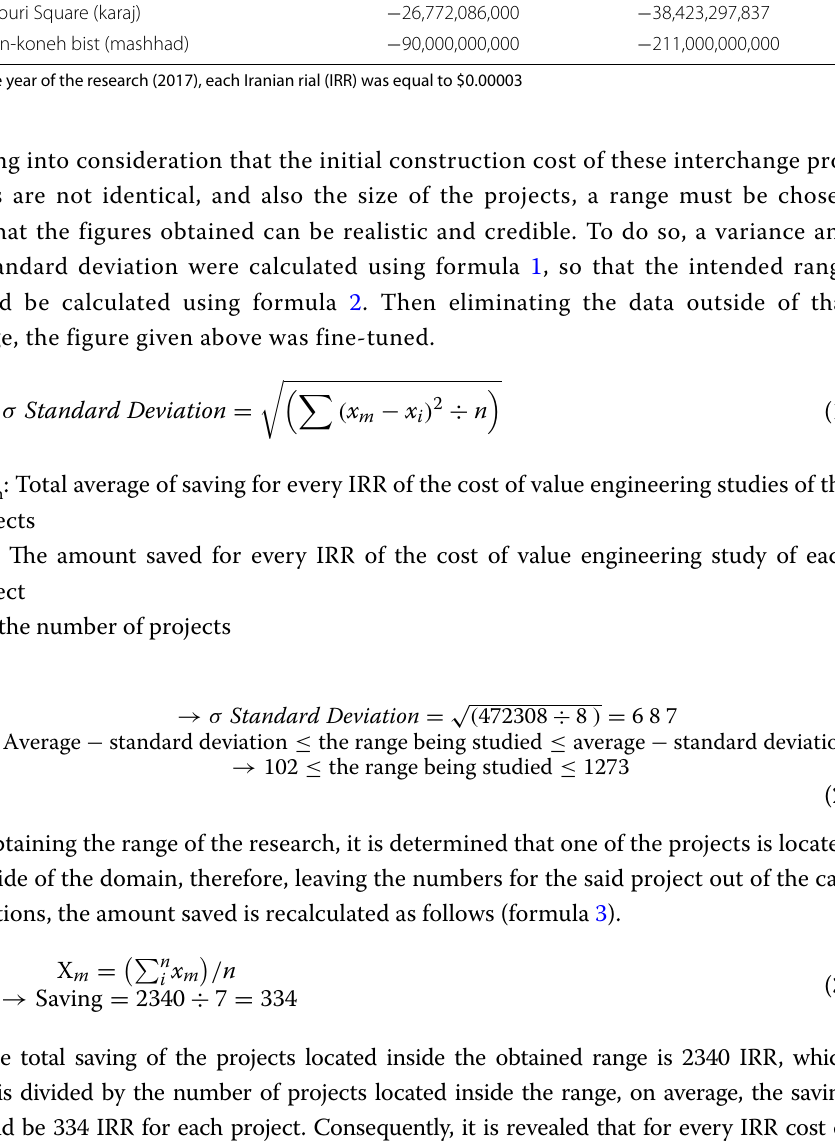
*In the year of the research (2017), each Iranian rial (IRR) was equal to $0.00003